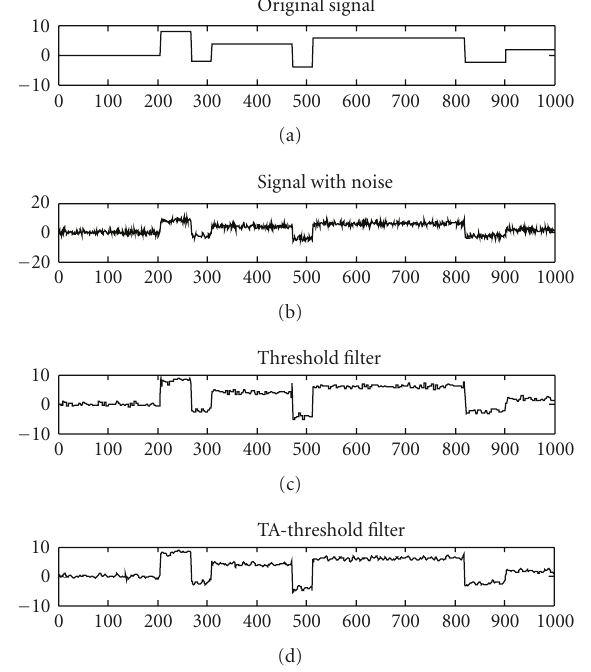
Figure 3: Comparison of two denoising methods.